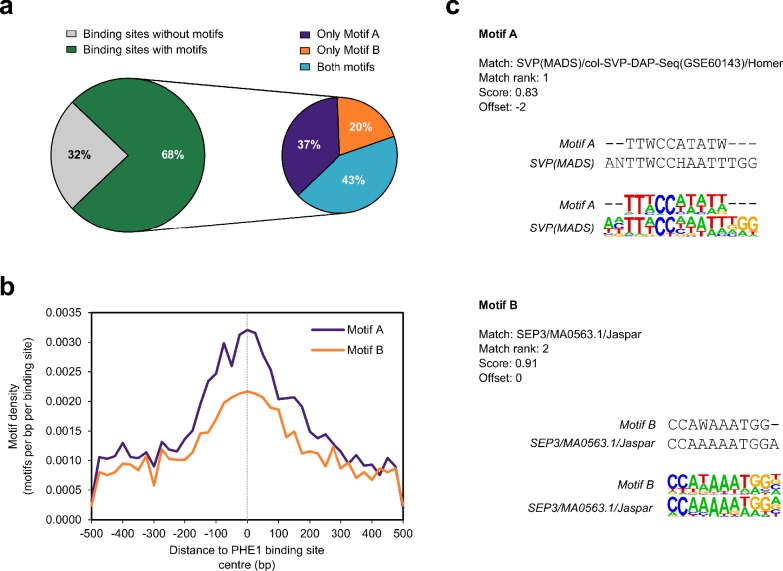
PHE1 DNA-binding motifs show similarity to type II MADS-box CArG-boxes.(a) Occurrence of PHE1-binding motifs in PHE1 binding sites. (b) Density of PHE1-binding motifs across PHE1 binding sites. (c) Alignment between PHE1-binding motifs and known motif matches. Both motifs match with previously characterized type II MADS-box CArG-boxes.